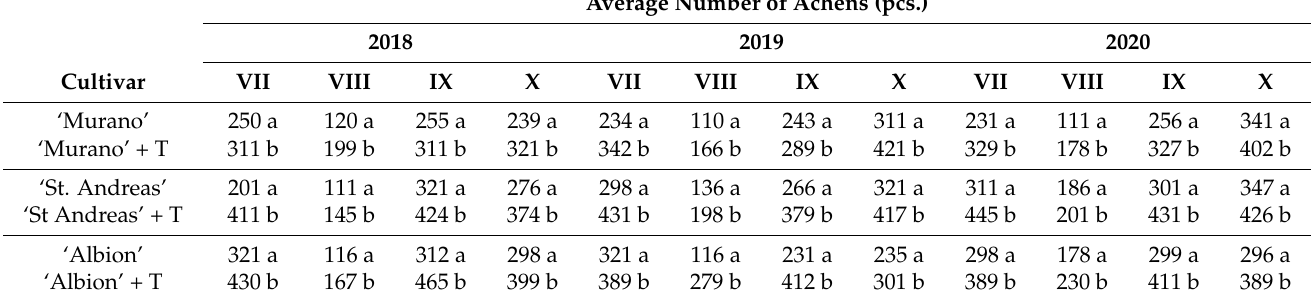
Table 4. The effect of titanium organic complex on average number of achenes on the fruit of three strawberry cultivars (pcs.). Average Number of Achens